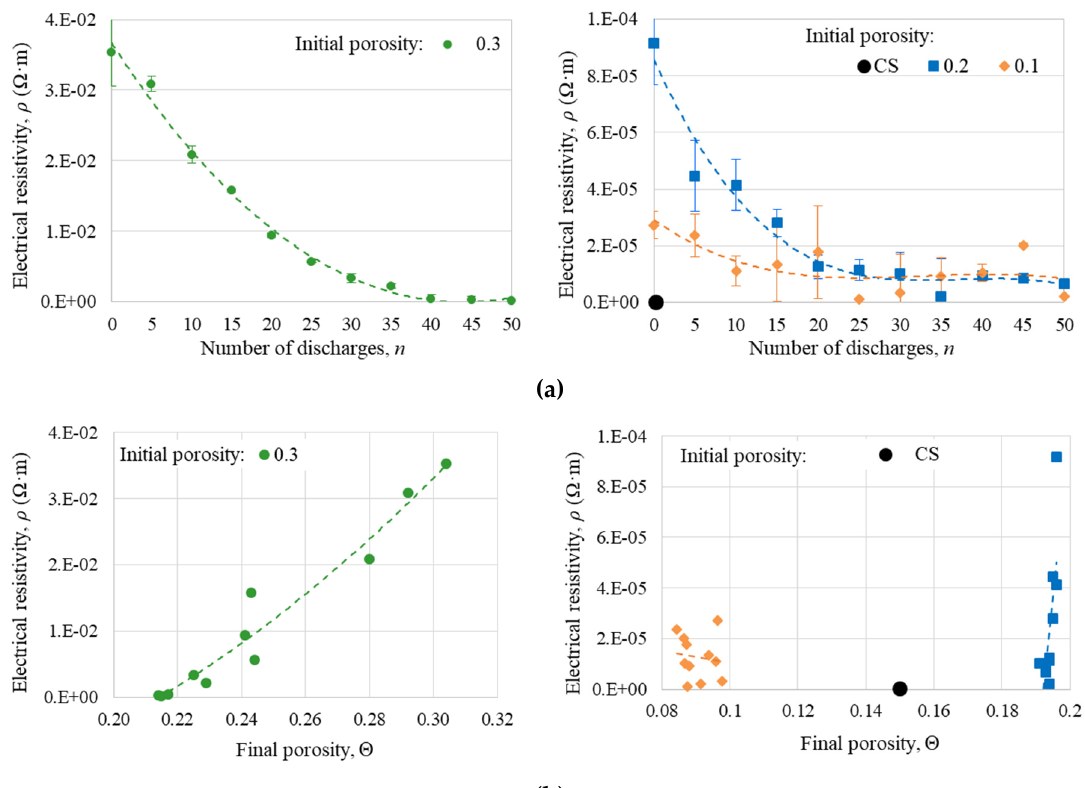
Figure 8. Electrical resistivity for the different CDEC compacts vs. ( a ) number of discharge and ( b ) final porosity. The value for the conventionally sintered specimen (CS) is also shown.